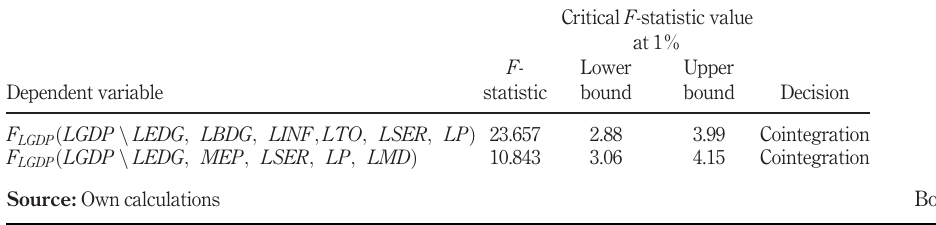
Table 6. Bound test results